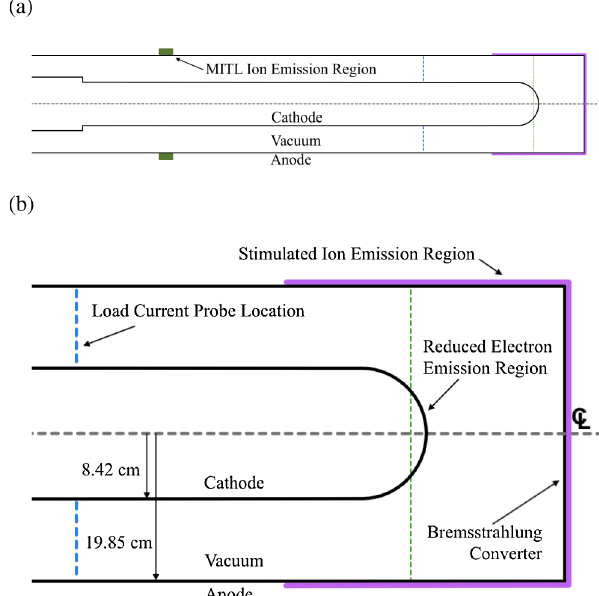
FIG. 3. (a) Geometry of the MITL PIC simulations. The green regions on the outer conductor upstream in the MITL indicate the 5 cm long region of ion emission. The outer anode radius is 19.85 cm, the inner cathode radius is 8.42 cm, and the inner radius in the upstream transition region is 10.46 cm. (b) Diagram of the diode region of the MITL simulation. The axial distance between the cathode hemisphere and the anode endplate is 18 cm. The following are shown in both (a) and (b). The last two axial centimeters of the center conductor define the region of reduced electron emission, and is indicated by the dashed green line. The region of stimulated anode ion emission is shown in magenta on the outer conductor. The axial location of the current probes (63 cm back from the anode endplate) is shown by the blue dashed